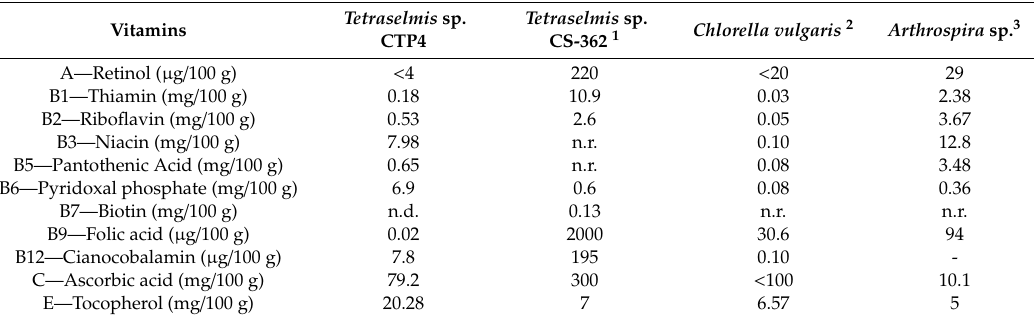
Table 5. Vitamin contents of Tetraselmis sp. CTP4 biomass grown semi-continuously in industrial tubular photobioreactors. Values from the literature for Tetraselmis sp. as well as Chlorella vulgaris and Arthrospira sp. are also presented. n.d.— not detected; n.r.—not reported. Tetraselmis sp. Tetraselmis sp. Vitamins Chlorella vulgaris 2 Arthrospira sp. CTP4 CS-362 1